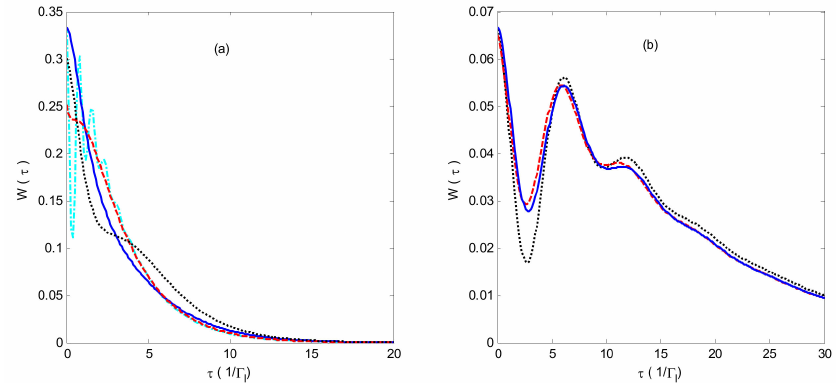
Figure 5. WTDs as a function of time τ . ( a ) Γ l = Γ 0 and ( b ) Γ l = 0.2 Γ 0 . The blue solid line is constructive ( η = 1), red dashed line is destructive ( η = − 1), and black dotted line is η = exp ( i π /2 ) , with δε = Γ 0 , α = 0.2; The cyan dot-dashed line is constructive ( η = 1, Γ l = Γ 0 , δε = 8 Γ 0 , α =